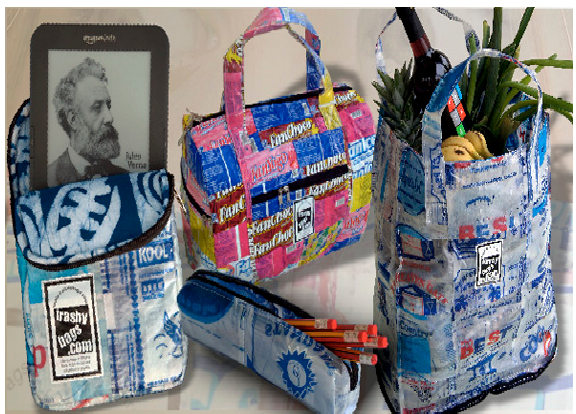
Figure 2. Bags created from plastics collected from the environment. Source: Trashy Bags [39].